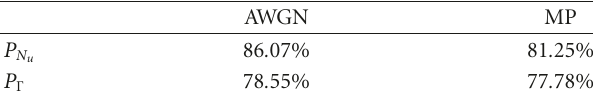
Table 3: User separation performances when received powers depend on user distances.